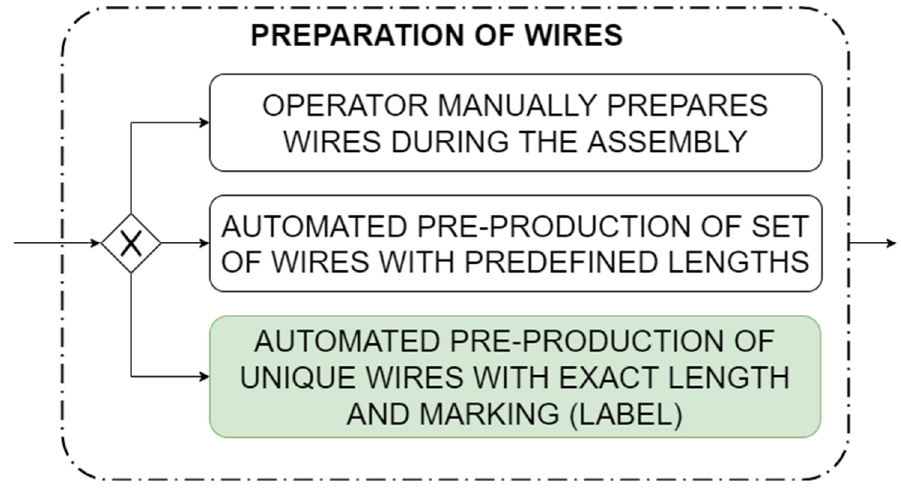
Figure 2. Subordinate process of preproduction of wires with three variants.